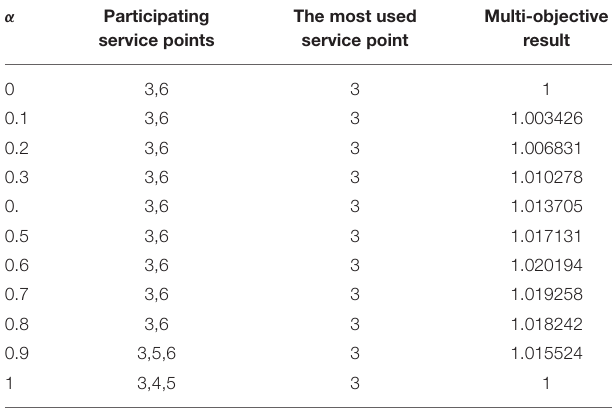
TABLE 3 | Mobile emergency facility service point information.